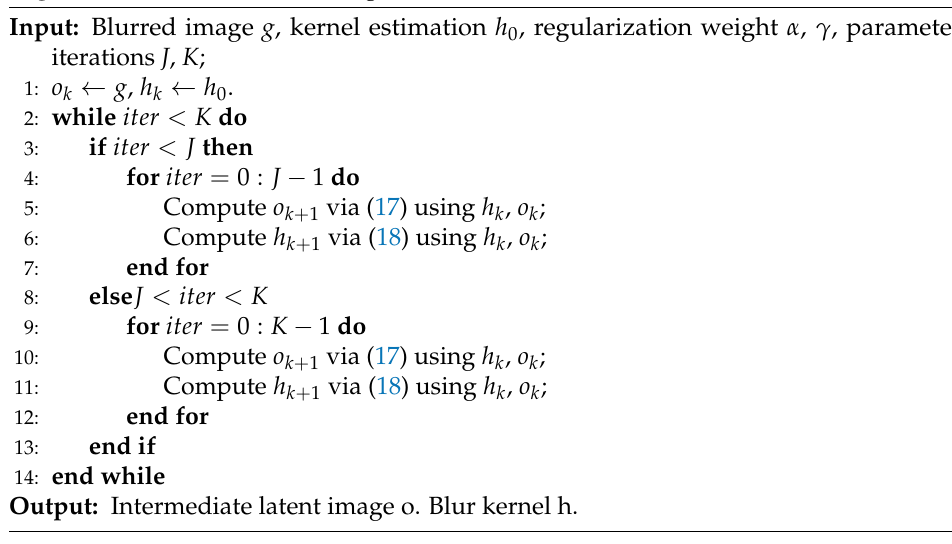
Algorithm 1 Estimate latent image